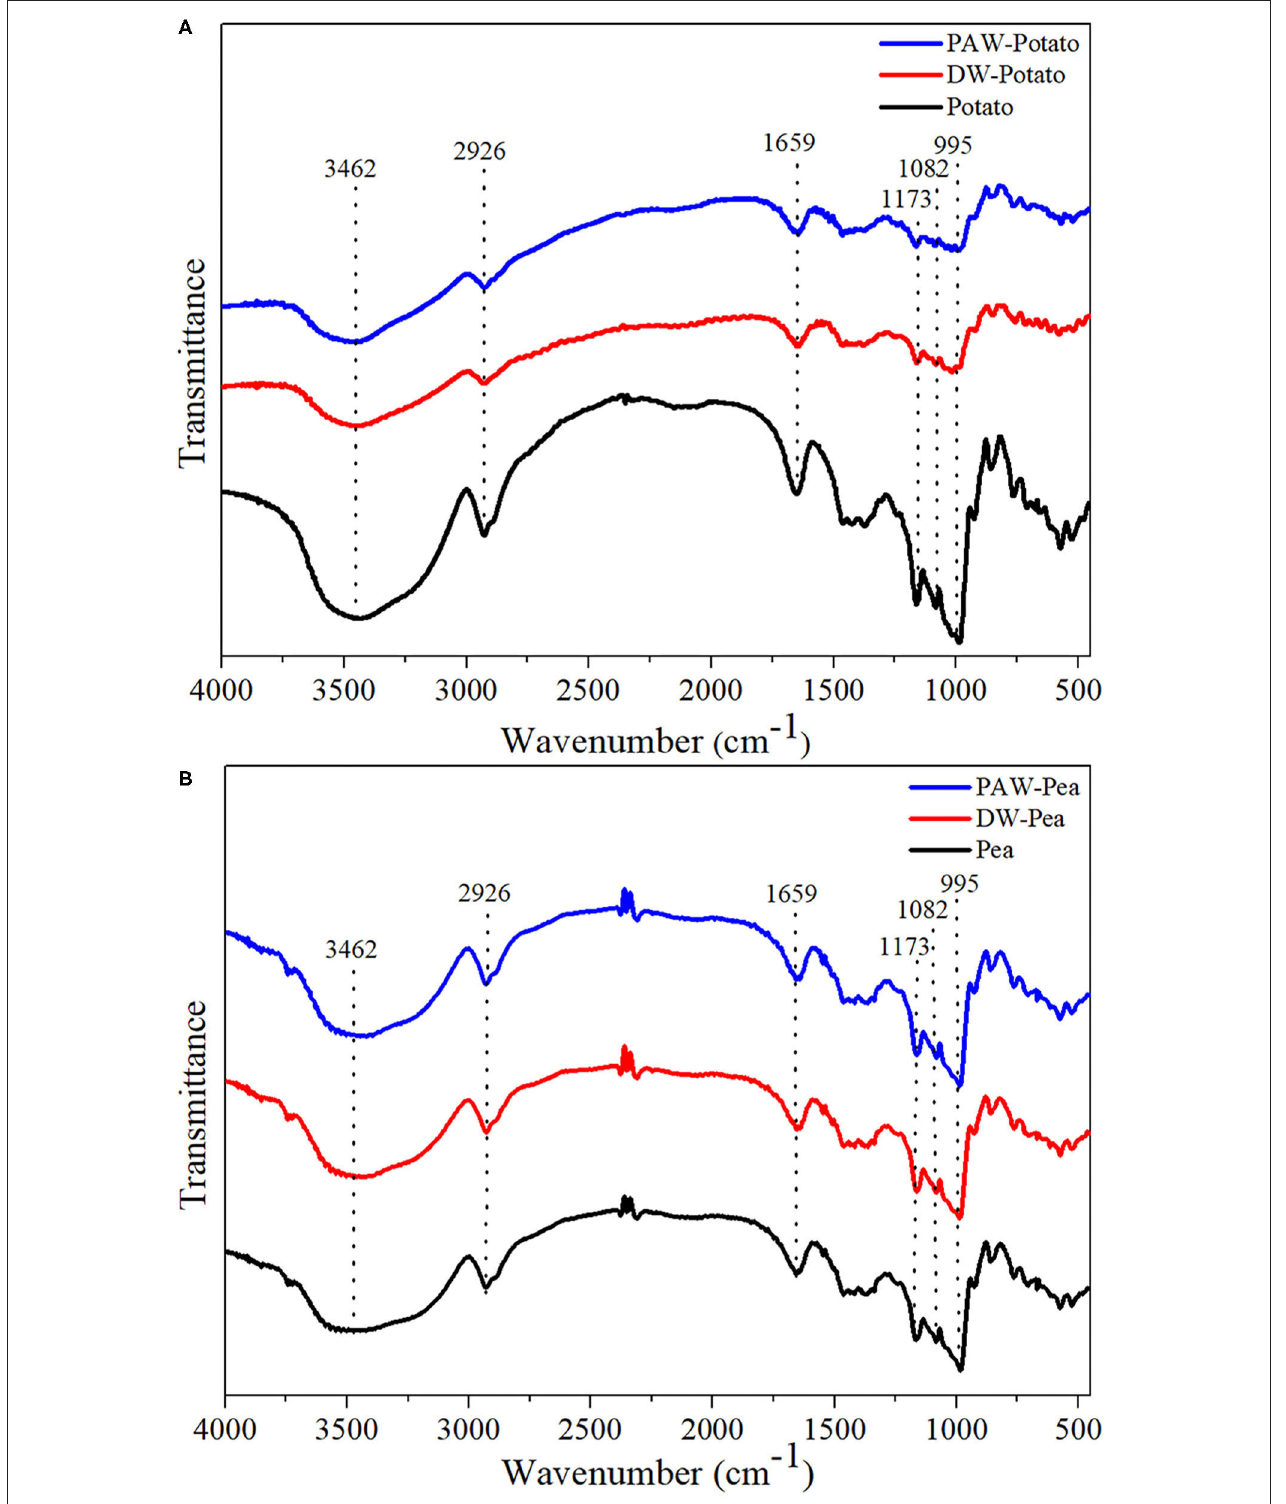
FIGURE 4 | Fourier transform infrared (FTIR) spectra of native and modified starches. (A) Native, DW-ANN treated, and PAW-ANN treated potato starch. (B) Native, DW-ANN treated, and PAW-ANN treated pea starch.